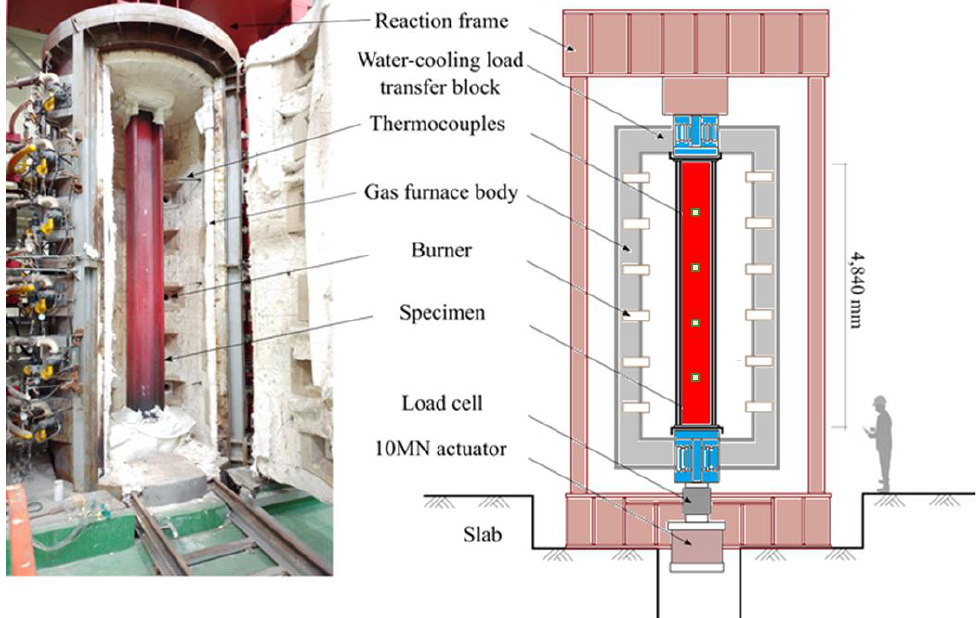
Figure 4. Benchmark experimental setup with column furnace and steel column [26].